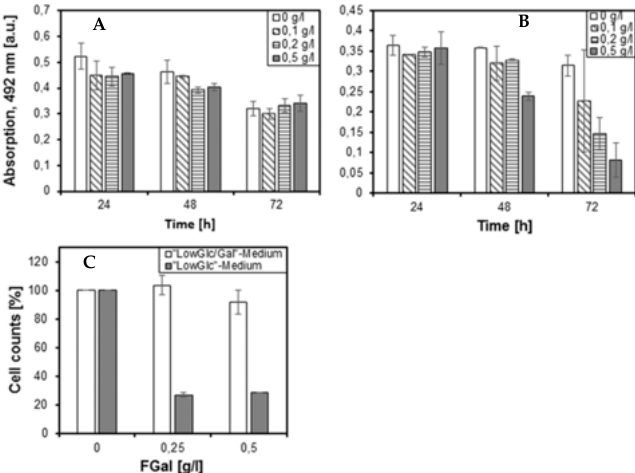
Figure 3. Time- and concentration-dependent viability of HEK293 cells in the presence of F-Gal. Cell viability (3-(4,5-dimethylthiazol-2-yl)-5-(3-carboxymethoxyphenyl)-2-(4-sulfophenyl)-2H-tetrazolium, MTS, staining) is shown after 24–72 h of cultivation in low-Glc/low-Gal medium ( A ) or low-Glc medium ( B ) in the absence or presence of varying concentrations of F-Gal (0–0.5 g/L). Growth rates were measured by counting cells after 72 h cultivation in either low-Glc/low-Gal or low-Glc medium in the absence or presence of inhibitor ( C ).